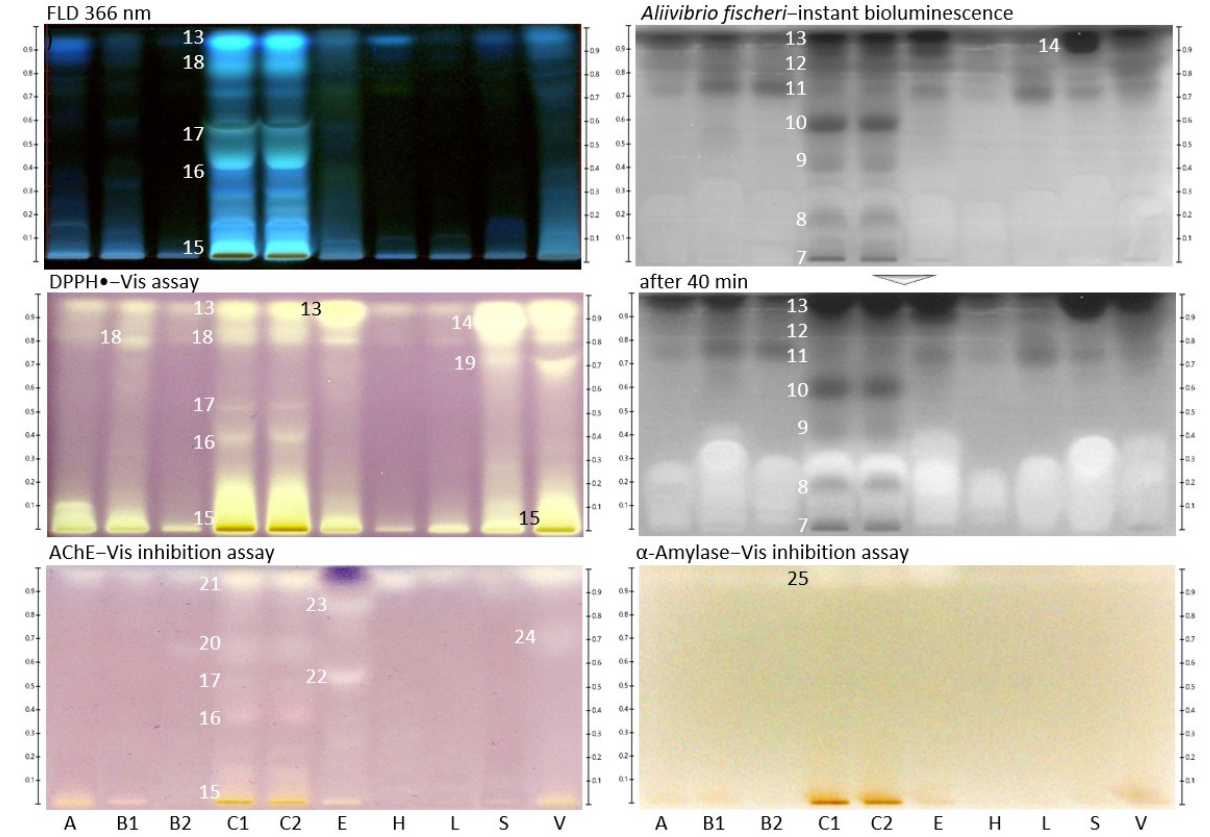
Figure 2. Chromatogram at FLD 366 nm and respective effect-directed profiling of 10 monofloral honey extract samples (assigned as in Table 1; 5 µ L/band for Aliivibrio fischeri bioassay, others 3 µ L/band each) developed on HPTLC silica gel 60 F 254 plates with ethyl acetate–methanol 3:2, V / V , detected via the Aliivibrio fischeri bioassay (bioluminescence recorded as greyscale image instantly and after 40 min) as well as DPPH • , AChE, and α -amylase inhibition assays (white light illumination, Vis), revealing the bioactive zones 7 – 25